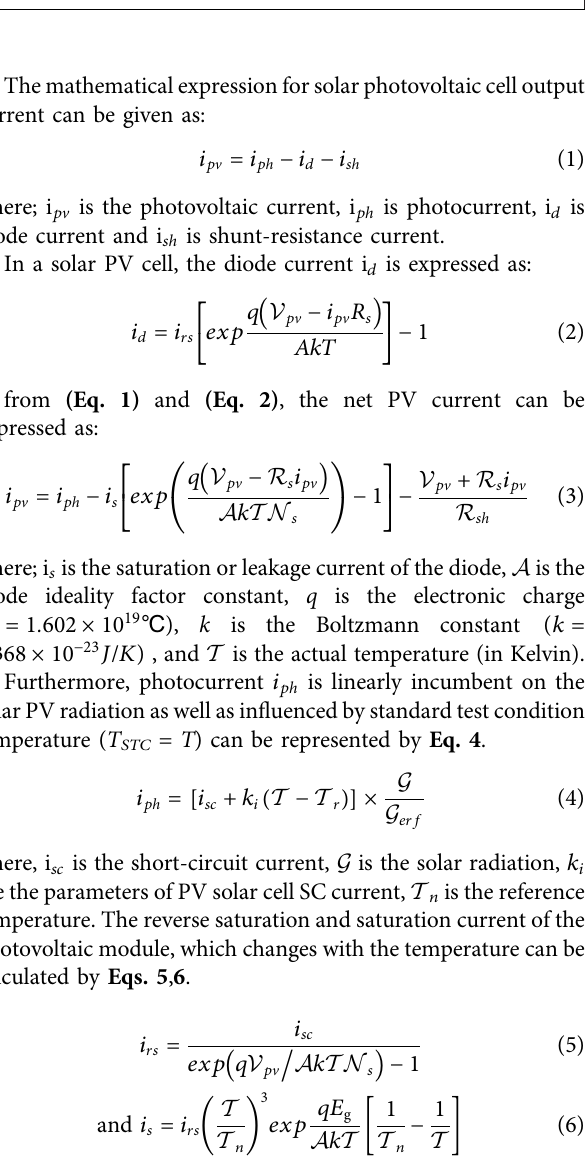
FIGURE 4 | Equivalent circuit diagram of boost converter topology: (A) On-state, and (B)